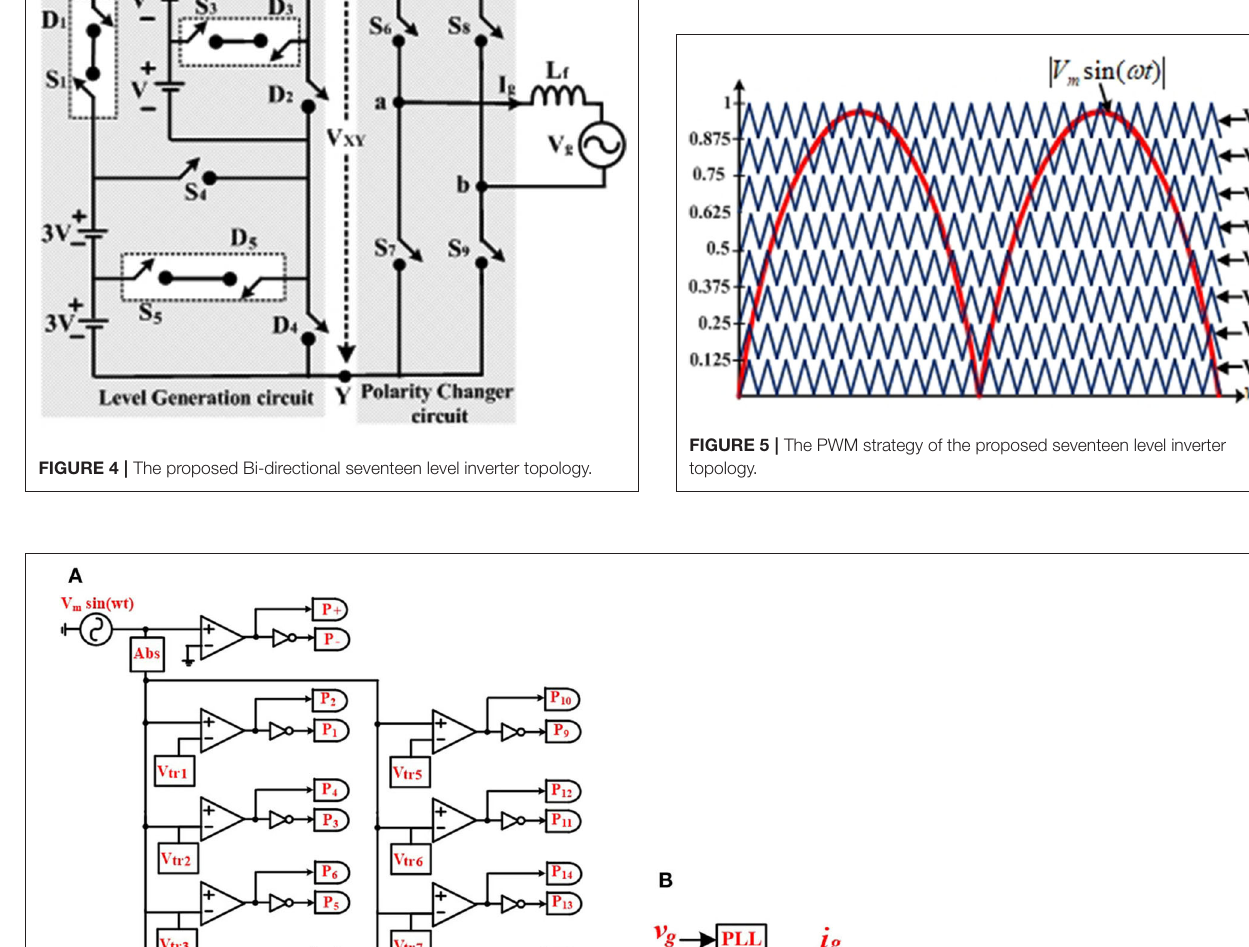
Frontiers in Energy Research |